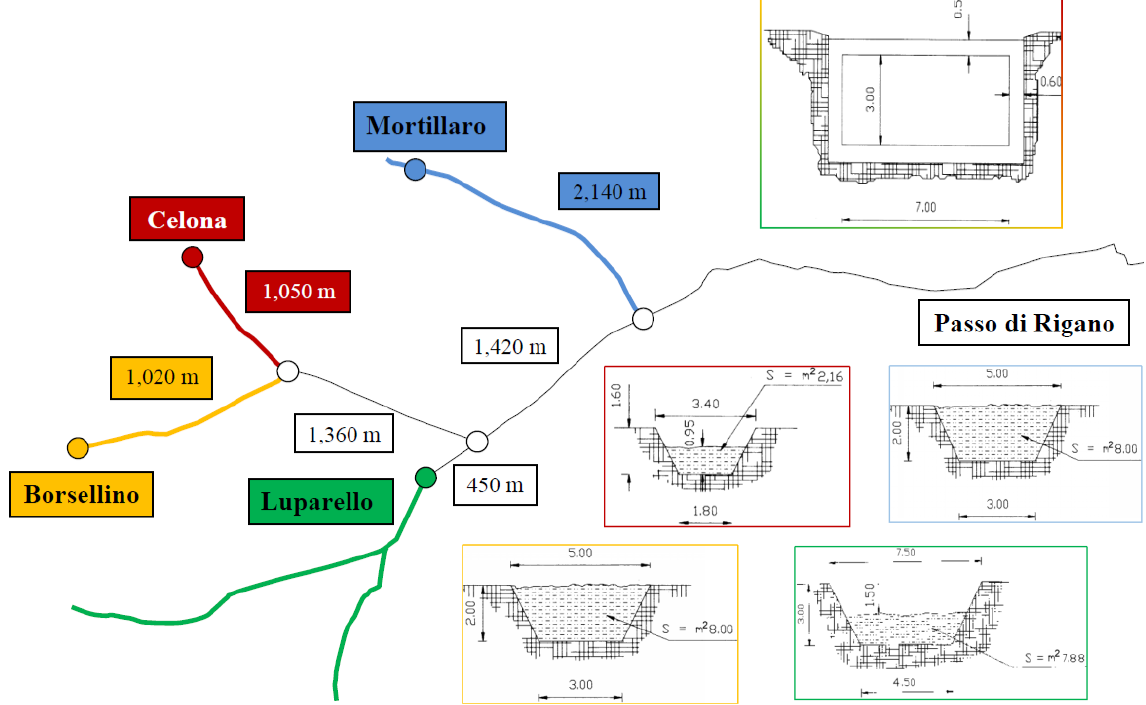
Figure 2. The Passo di Rigano drainage system for the conveying and regulating rainwater in the study area. The yellow color is associated with Borsellino, red with Celona, green with Luparello, and blue with Mortillaro channels; the box with mixed colors (red, yellow, and green) refers to the section of the Luparello channel downstream of the confluence with the Borsellino and Celona